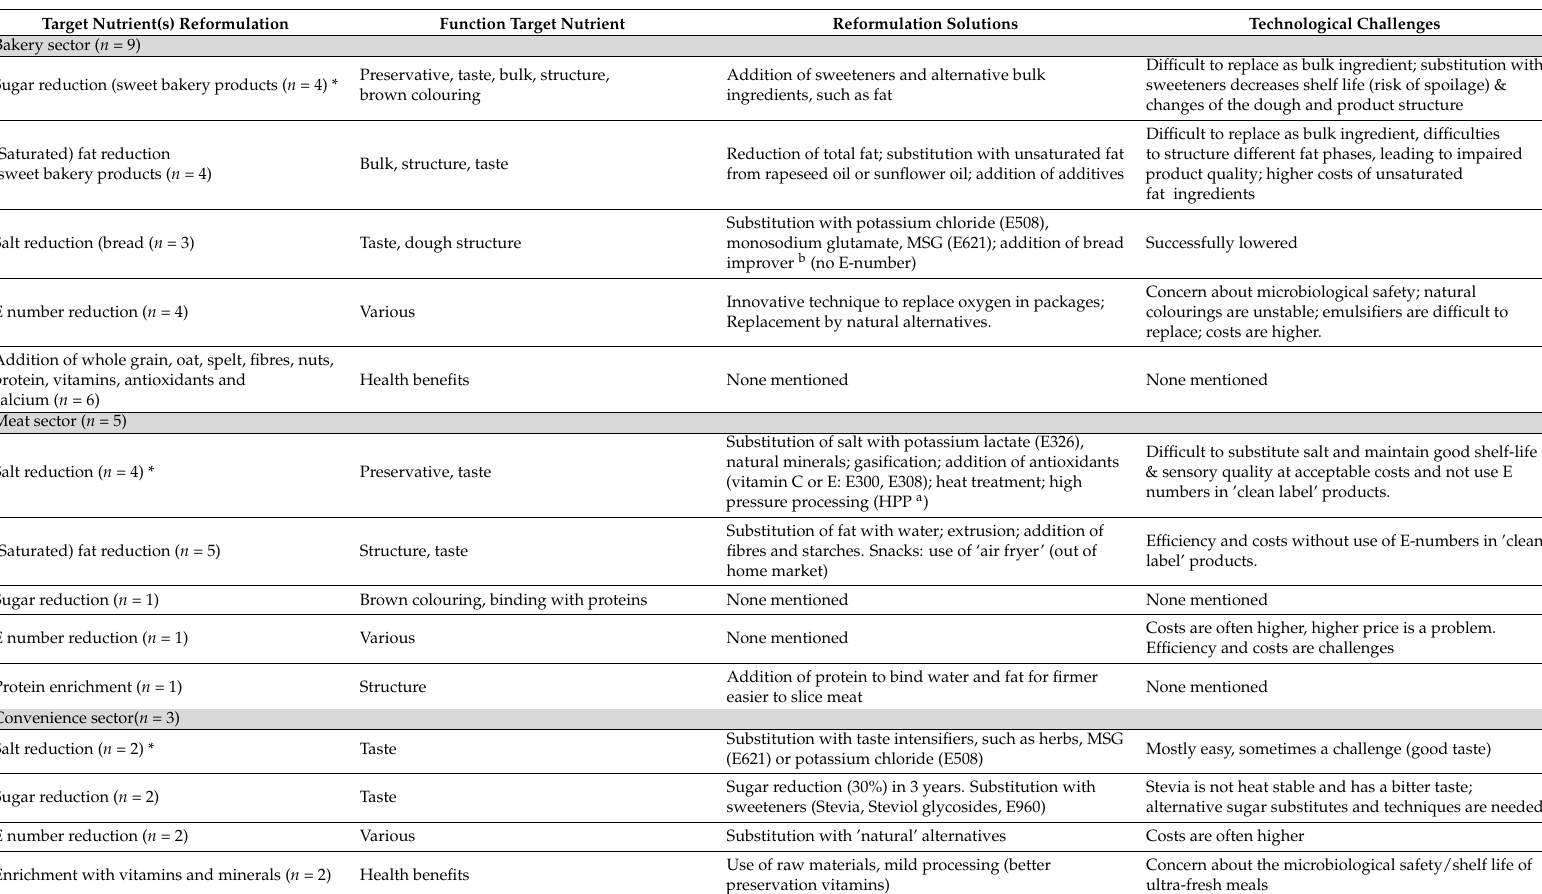
Table 3. Overview of food technological aspects that were mentioned in the interviews: target nutrients for reformulation, their function, technological solutions and challenges. In total, 17 companies from bakery ( n = 9), meat ( n = 5) and convenience ( n = 3)